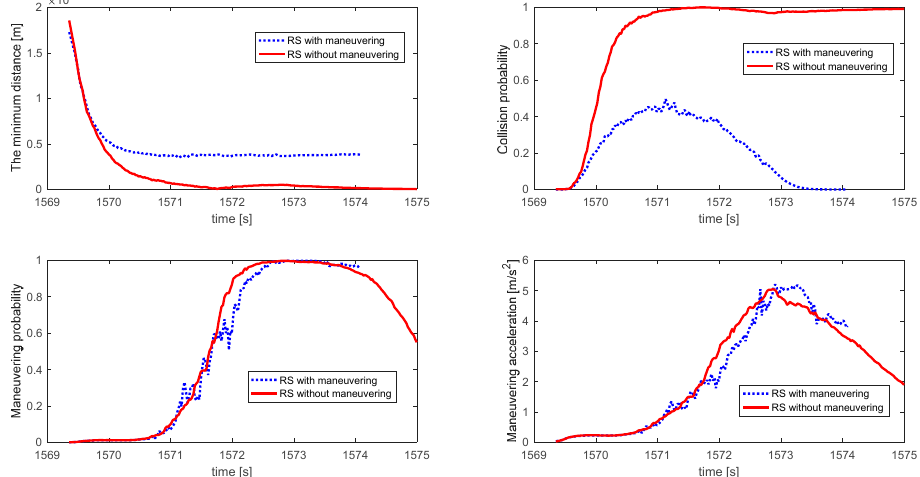
Figure 14. Minimum distances and collision probability between NCSO and RS, and maneuvering probability and maneuvering accelerations of NCSO for third simulation.